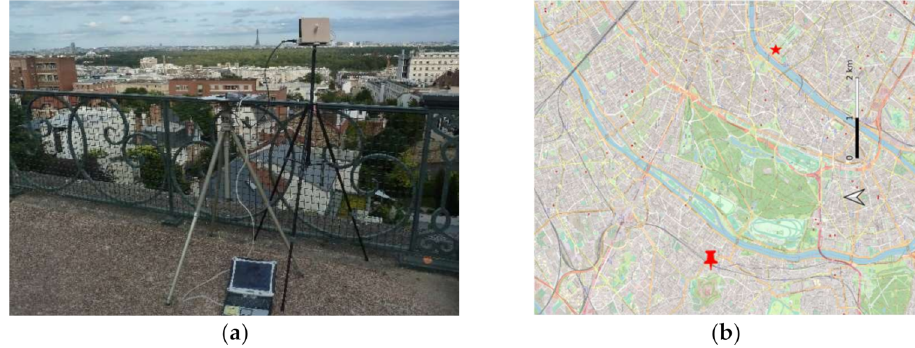
Figure 14. ( a ) Setup of the experiment conducted in Paris, France, at the Mont Valerien location and ( b ) the aerial picture of the imaging scene, where the experiment site is indicated by the red